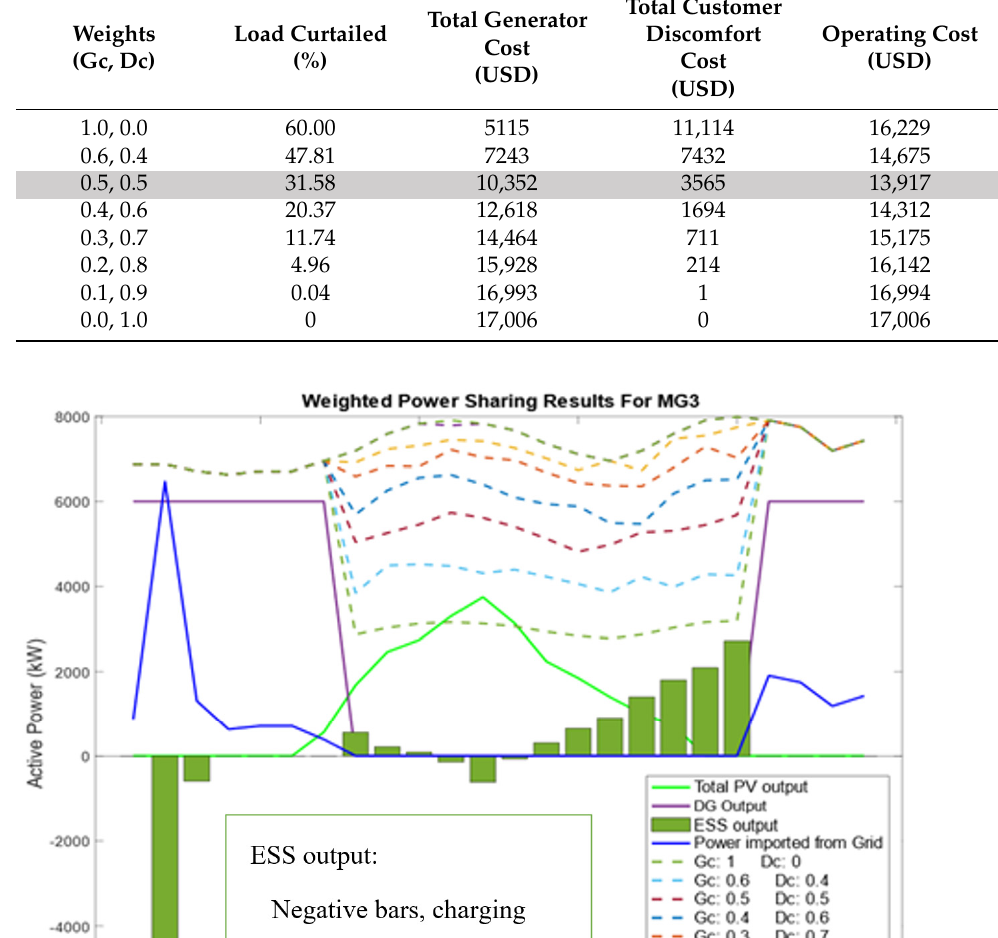
Table 2. Weighted Power Request Options (MG3).